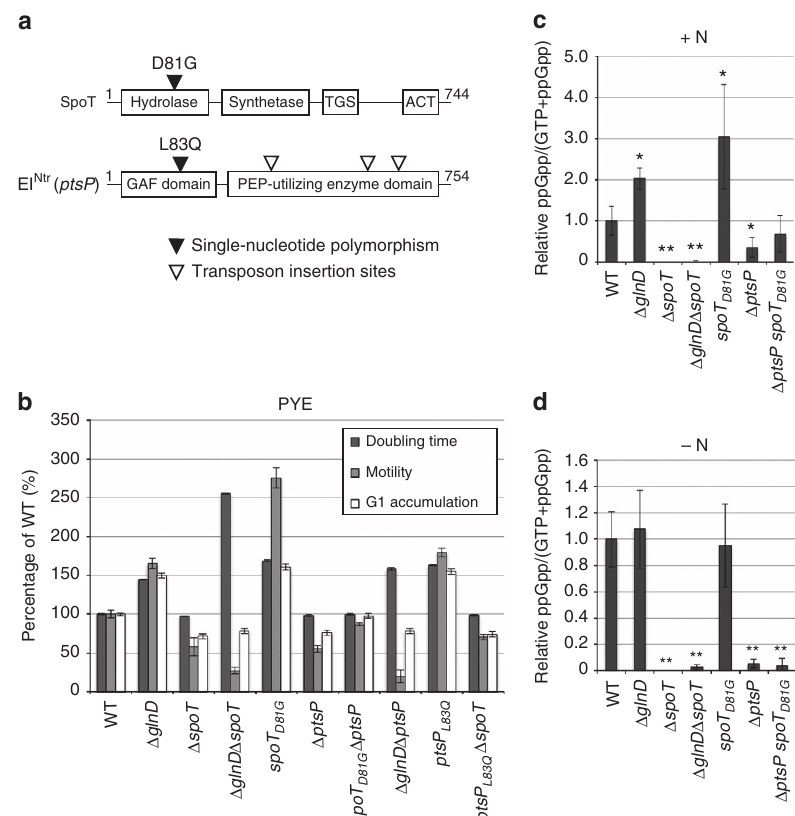
Figure 3 | SpoTand EI Ntr modulate (p)ppGpp accumulation on nitrogen starvation. ( a ) Mutations isolated in SpoTand EI Ntr that modulate G1/swarmer lifetime. Black arrowheads indicate the mutations ( spoT D81G and ptsP L83Q ) that increase G1/swarmer lifetime. White arrowheads indicate the positions of 3 himar transposon insertions in the ptsP locus out of the 16 that suppressed spoT D81G phenotypes. The exact positions of the remaining 13 transposon insertions into the ptsP locus were not determined. ( b ) SpoT and EI Ntr control G1/swarmer lifetime. Doubling time, motility and G1 proportion were measured in wild-type (WT; RH50), D glnD (RH577), D spoT (RH1755), D glnD D spoT (RH1756), spoT D81G (RH1752), D ptsP (RH1758), D ptsP spoT D81G (RH1727) D glnD D ptsP (RH1940), ptsP L83Q (RH1748) and D spoT ptsP L83Q (RH1728) grown in complex media (PYE) and normalized to the WT (100%). Error bars ¼ s.d.; n ¼ 3. ( c , d ) Glutamine auxotrophy leads to (p)ppGpp accumulation. Intracellular levels of (p)ppGpp detected by TLC after nucleotides extraction of WT (RH50), D glnD (RH577), D spoT (RH1755), D glnD D spoT (RH1756), spoT D81G (RH1752), D ptsP (RH1758) and D ptsP spoT D81G (RH1727) grown ( c ) in þ N or ( d ) (cid:2) N conditions. Error bars ¼ s.d.; n ¼ 3. Statistically significant differences by Student’s t -test in comparison with the WT are indicated as * P o 0.05% and ** P o 0.01% ( n ¼